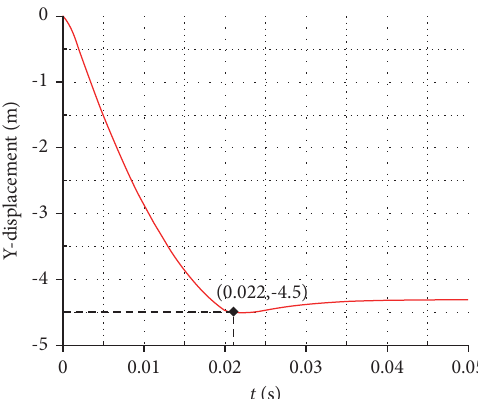
Figure 5: Time history curve for displacement of projectile